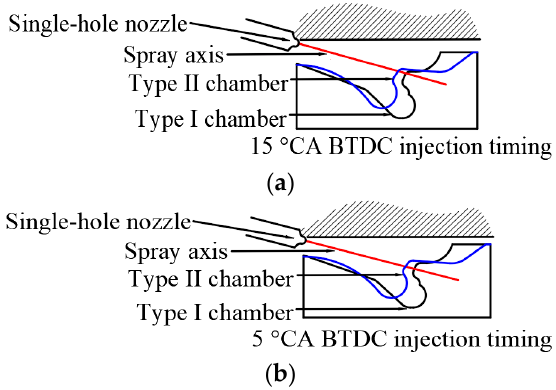
Figure 6. Schematic diagram of the relative positions between the spray axis and the piston position at different injection timings. ( a ) 15 ◦ CA BTDC (crank angle before top dead center) injection timing; ( b ) 5 ◦ CA BTDC injection timing.